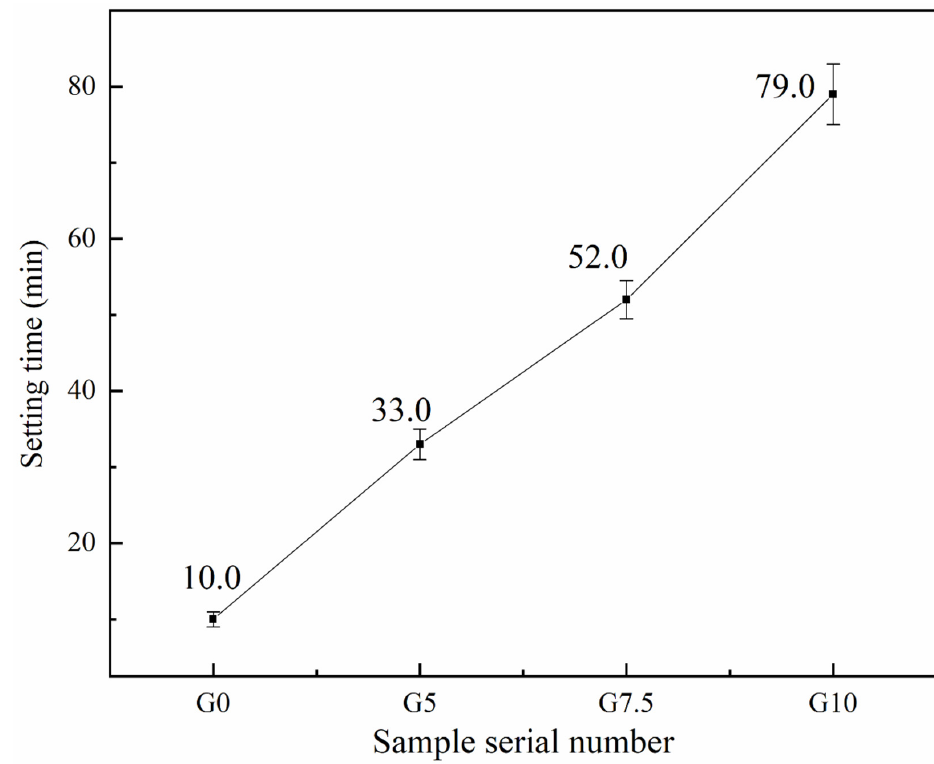
Figure 4. E ff ect of di ff erent water glass contents on the se tt ing time of MPC at − 5 °C. Figure 4. Effect of different water glass contents on the setting time of MPC at − 5 ◦ C.